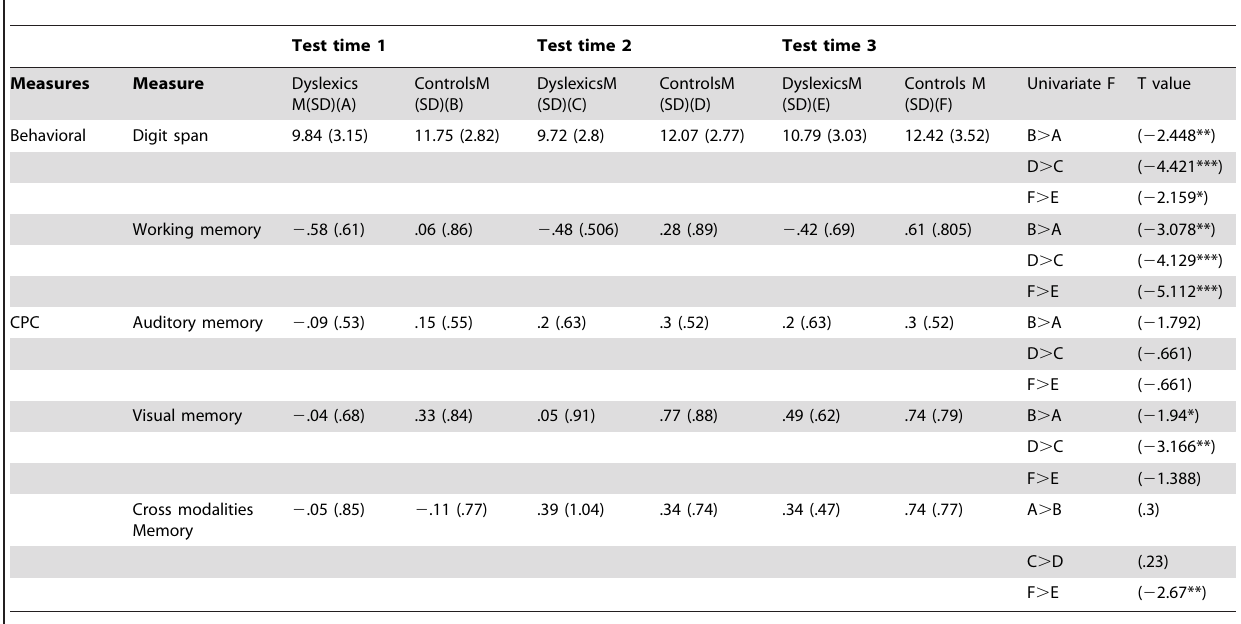
Table 3. A comparison of dyslexics and controls on memory measures for all tests.